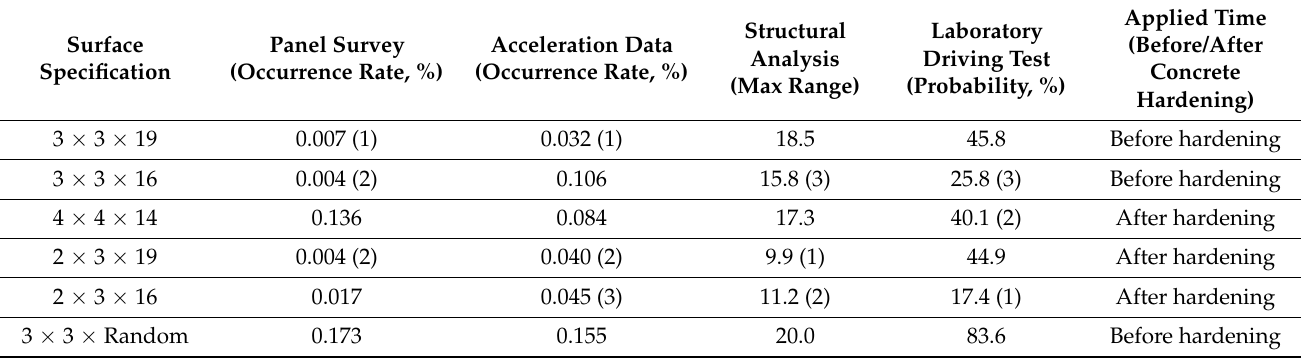
Table 8. Test results of longitudinal texturing